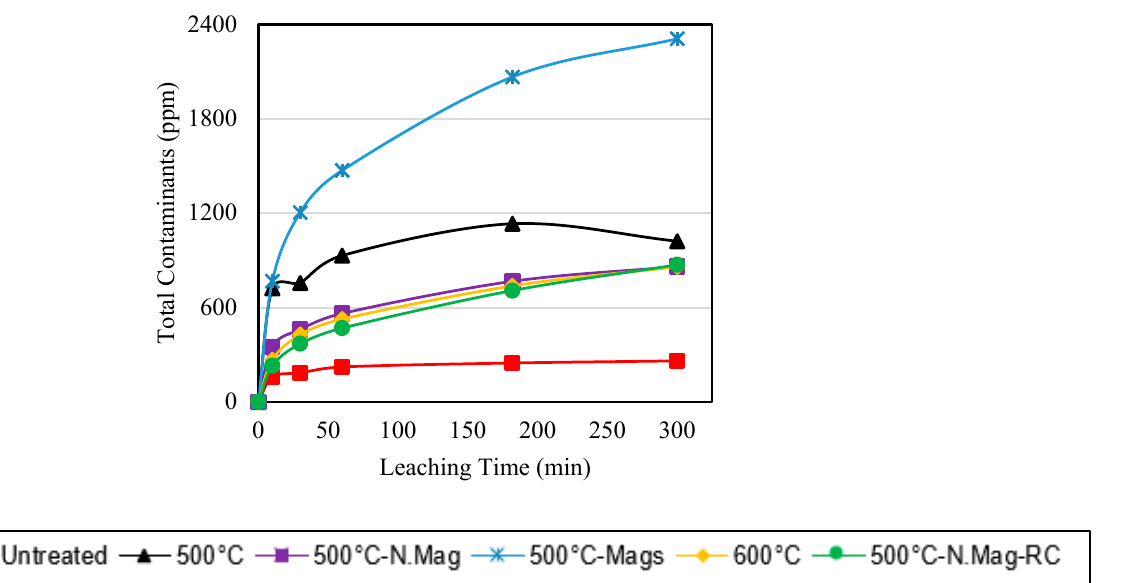
Figure 11. Acid leaching test results with 1.2M H 2 SO 4 for the 2.20 SG sink calcined products at different temperatures. (Mags = Magnetic; N. Mag = Non-magnetic; N. Mag-RC = Non-magnetic fraction re-calcined at 600 °C).